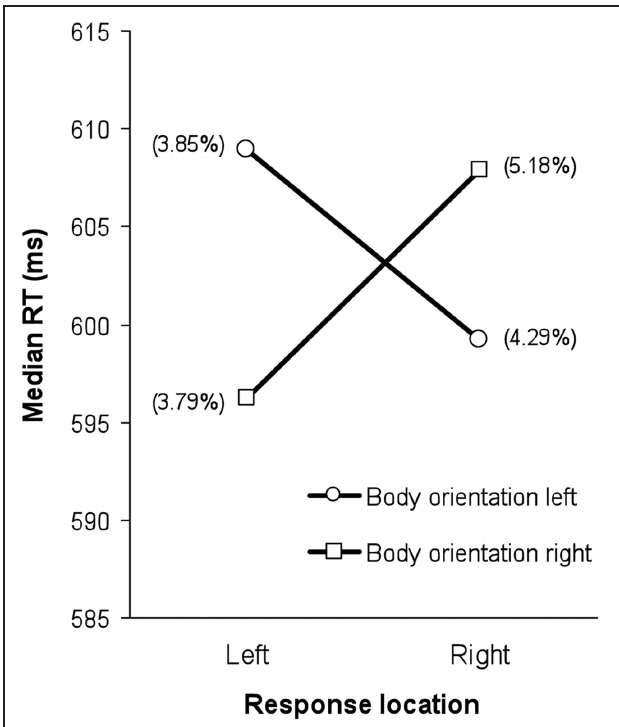
FIGURE 3 | Median reaction times (ms) as a function of response location and body orientation. Mean error rates (%) are shown between